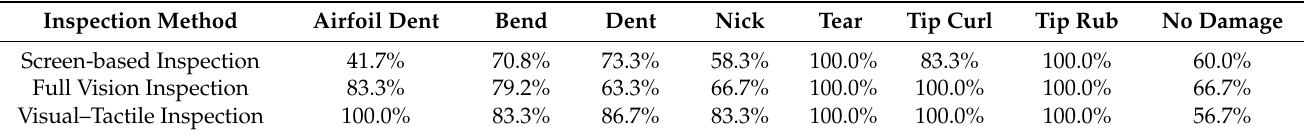
Table 6. Inspection accuracy of each inspection method by defect